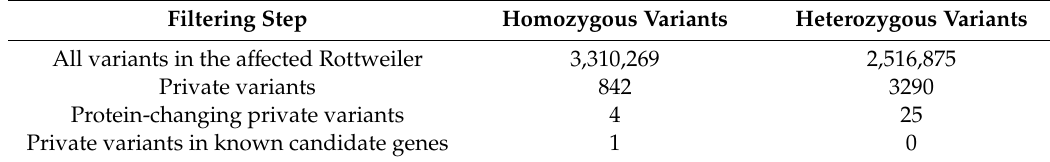
Table 2. Results of variant filtering in the a ff ected Rottweiler dog against 655 control genomes.